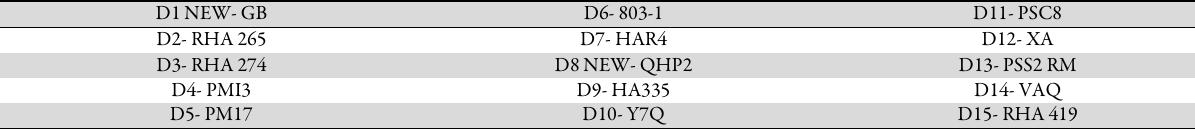
Table 1. Sunflower differential lines used as positive control to identify Pl 5 and Pl 16 resistance genes D1 NEW- GB